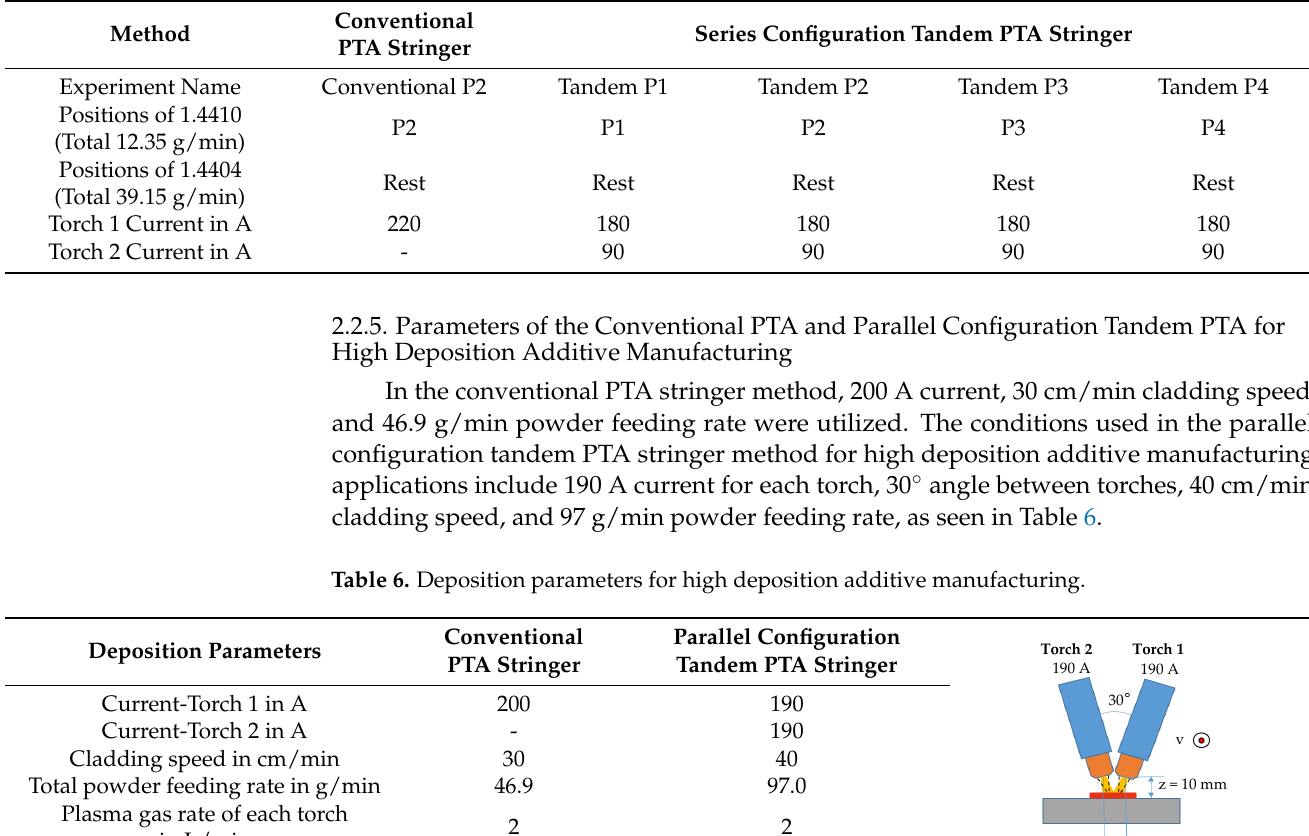
Table 5. Powder position and current values of experiments for multi-material coating.